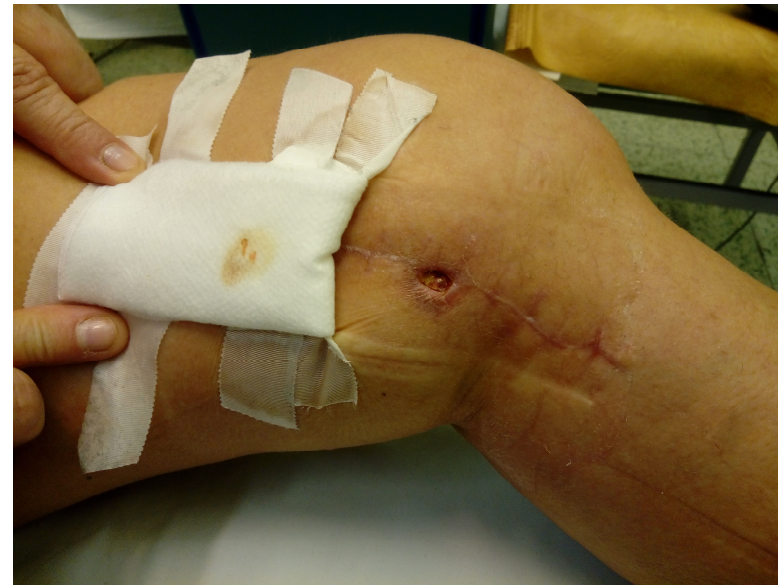
Figure 1. The local state of wound before the topical ozone therapy procedures.